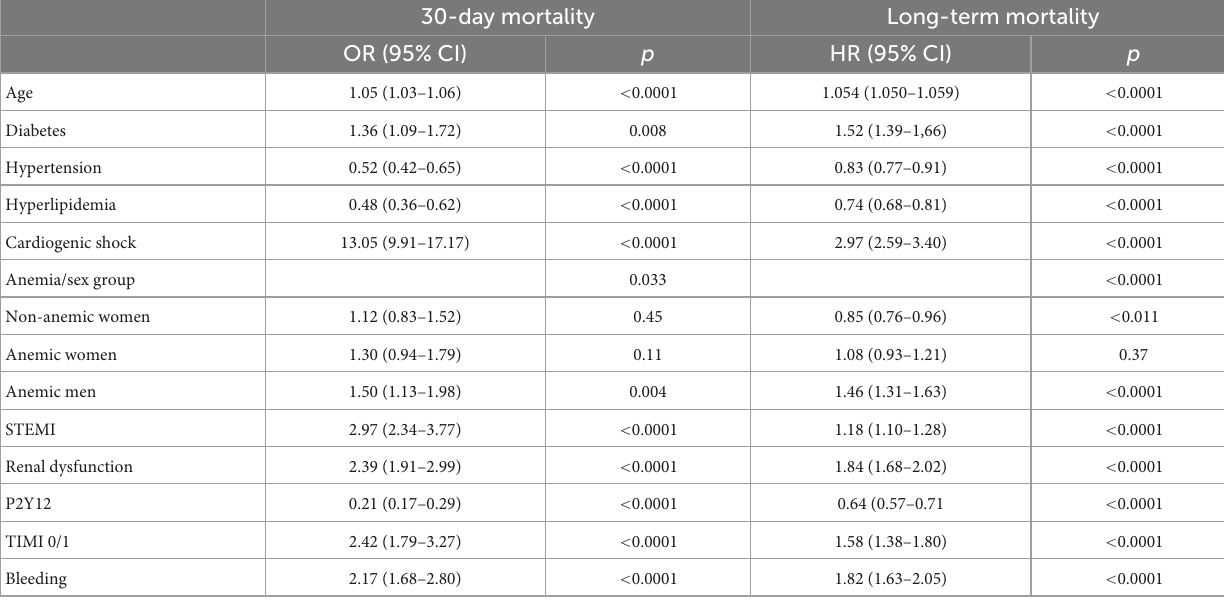
TABLE 3 Predictors of 30-day and long-term mortality (non-anemic men as the reference group). 30-day mortality Long-term